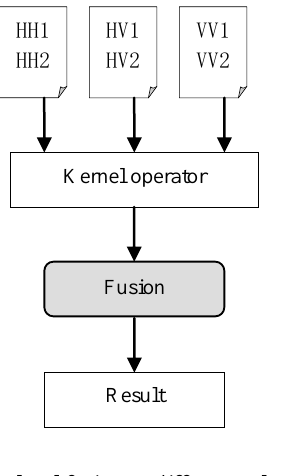
Figure 2 Decision-level fusion on different polarimetric images to detect changes